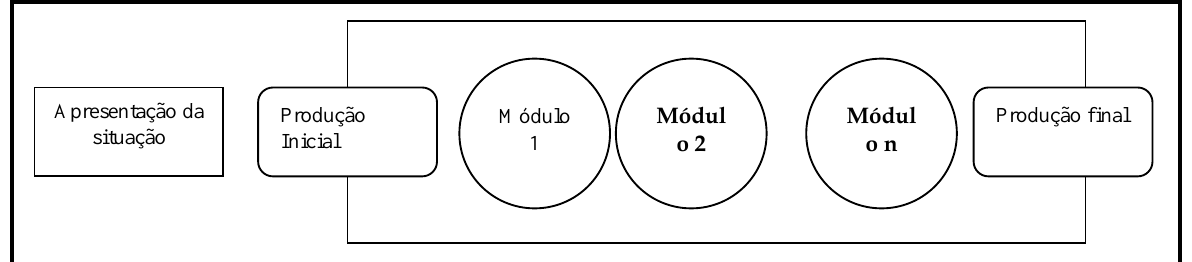
Figura 1. Esquema de Seqüência Didática. (DOLZ, NOVERRAZ & SCHNEUWLY, 2004,